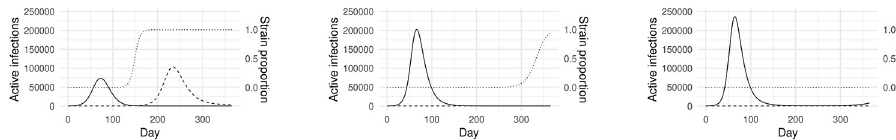
Fig 1. Example simulation results from a two-strain SIRS model with a vaccinated population, for different vaccination rates. The solid line shows the number of active infections for Strain 1. The dashed line shows the number of active infections for Strain 2. The dotted line shows the proportion of the two strains. Vaccine resistant strain initially present at rate of 10 − 6 . ( a ) 50% population vaccinated in 100 days. ( b ) 10% population vaccinated in 100 days. ( c ) No